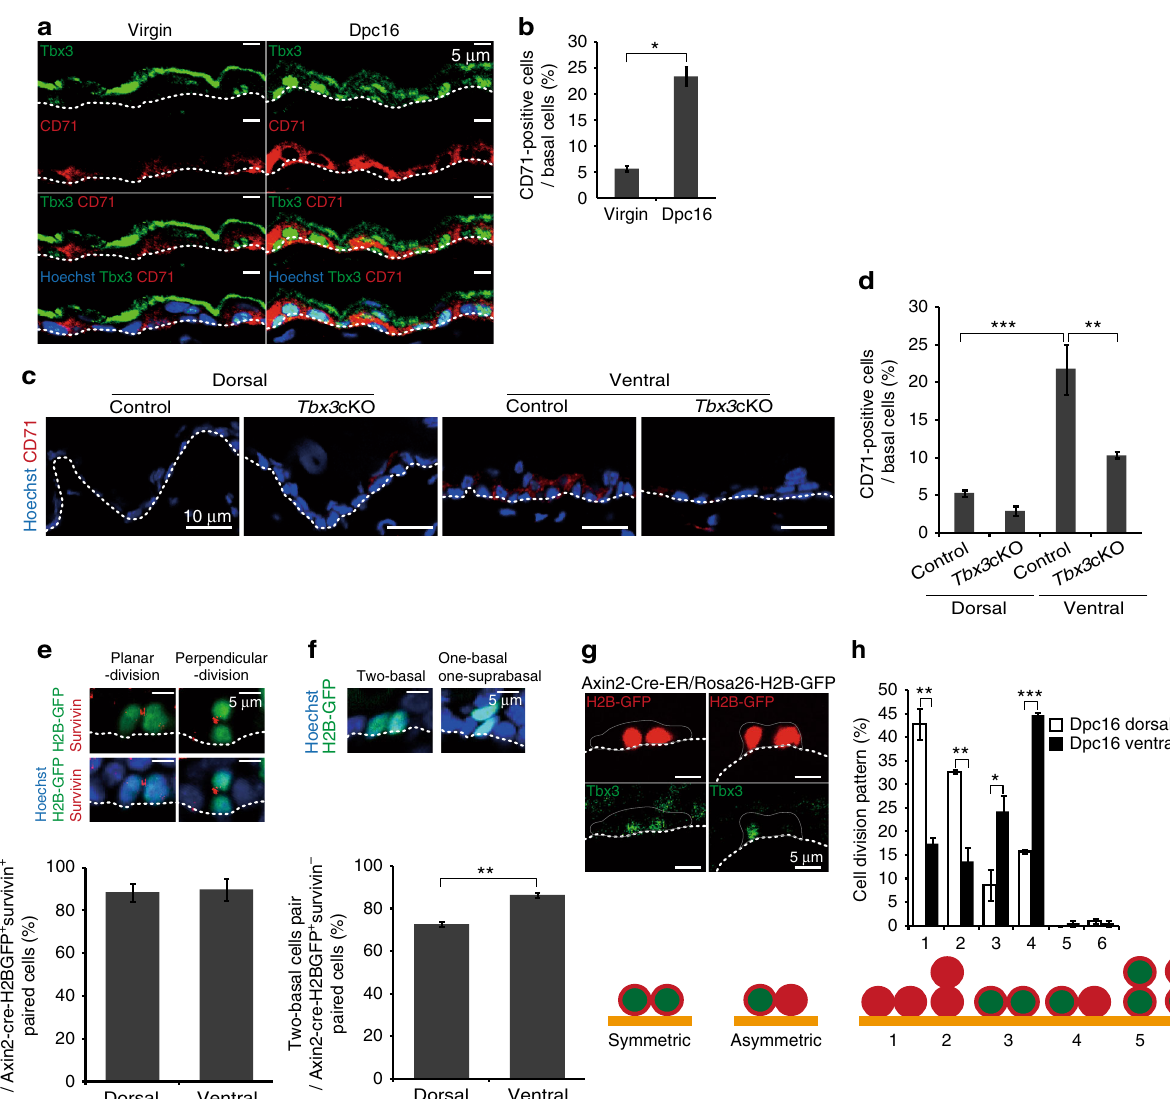
Fig. 4 Axin2 + IFE stem cells generate Tbx3 + basal cells through planar-oriented symmetric/asymmetric cell division. a Immuno fl uoresence of Tbx3 ( green ), CD71 ( red ) and Hoechst ( blue ) on ventral skin from virgin and 16 dpc mice. b Quanti fi cation of CD71 + cells in IFE basal layers. c Immuno fl uoresence of CD71 ( red ) and Hoechst ( blue ) on tamoxifen-treated dorsal and ventral skin from 16 dpc control and Tbx3 cKO mice interbred with genetically unaltered males. d Quanti fi cation of CD71 + cells in IFE basal layers. e , f Immuno fl uoresence of GFP ( green ), survivin ( red ) and Hoechst ( blue ) on ventral skin from 16 dpc Axin2-Cre-ER/Rosa26-H2B-GFP mice. Quanti fi cation of planar-oriented IFE basal cell division in Axin2-Cre-ER labelled-survivin + cells ( e ) and the two basal cell pairs in Axin2-Cre-ER labelled-survivin − cells ( f ) are shown on the bottom . g Typical images of planar-oriented symmetric and asymmetric division of Axin2-Cre-ER-labelled IFE basal cells. h Quanti fi cation of the division pattern of Axin2-Cre-ER-labelled IFE basal cells in dorsal and ventral skin at 16 dpc. b , d – f , h Data represent the mean ± s.e.m. of averages of three independent experiments ( n = 3). > 500 cells ( b ), > 200 cells ( d ), > 40 cells ( e ), > 150 cells ( f ), > 50 cells ( h ) were analysed to calculate the average in each experiment; * P < 0.05, ** P < 0.01, *** P < 0.001, analysed by the Dunnett ’ s multiple comparison test ( d ), two-tailed t -test ( b , e , f ), or Tukey ’ s multiple comparison test ( h ). a , c , e , f , g White-dotted lines represent basement membranes. Experiments were repeated three times with three mice for representative images (Supplementary Fig. 3H, I; patterns 1 and 2). Conversely, the found that planar-oriented basal cell division was signi fi cantly abdominal epidermis of pregnant mice at 16 dpc displayed a increased in the abdominal epidermis compared with the dorsal signi fi cant increase in the population of IFE basal cells that epidermis at 16 dpc (Supplementary Fig. 3J). In addition, loss of divided parallel to the basement membrane by symmetric or Tbx3 attenuated the planar-oriented basal cell division signi fi - asymmetric cell division to gives rise to one or two Tbx3 + basal cantly in the abdominal epidermis, but only slightly in the dorsal cells (Supplementary Fig. 3H, I; patterns 3 and 4). The proportion epidermis at 16 dpc, indicating that the Tbx3 + IFE basal cells of parallel symmetric cell division (pattern 3) was higher in K14- emerging in abdominal skin of pregnant mice are predisposed to Cre-ER-labelled IFE basal cells compared with Axin2-Cre-ER- divide parallel to the basement membrane. Taken together, these labelled IFE basal cells (see Fig. 4h), implying planar cell division results demonstrate that the Axin2 + IFE basal cells in abdominal − ) IFE basal cells. Next, we examined the cell of Tbx3 + (Axin2 skin activate during pregnancy and undergo planar-oriented division orientation of IFE basal cells by staining for survivin. We asymmetric or symmetric cell division to give rise to the Tbx3 + NATURE COMMUNICATIONS | 8: 508 | DOI: 10.1038/s41467-017-00433-7 |